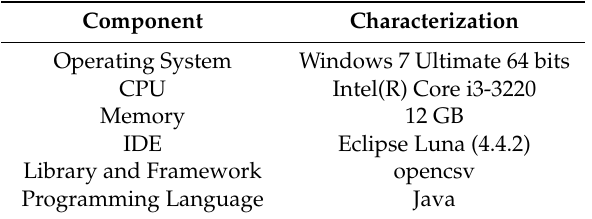
Table 6. Development environment of the optimal travel route recommender system.